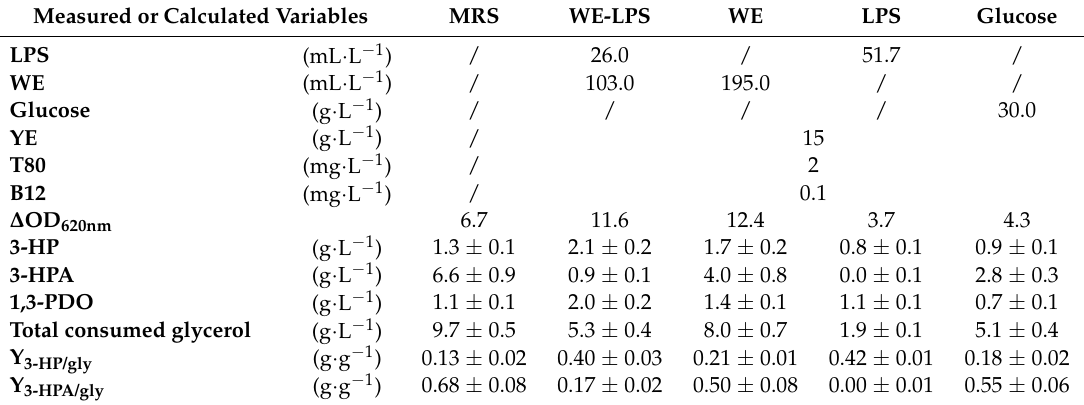
Table 2. Products of glycerol bioconversion obtained after the growth of L. reuteri in different culture media containing the same sugar concentration, but differing in their carbon source, compared to the standard medium MRS. The yield of glycerol conversion to 3-HP (Y 3-HP/gly ) and 3-HPA (Y 3-HPA/gly ) are expressed in g of product per g of glycerol consumed. Mean values and standard deviation of